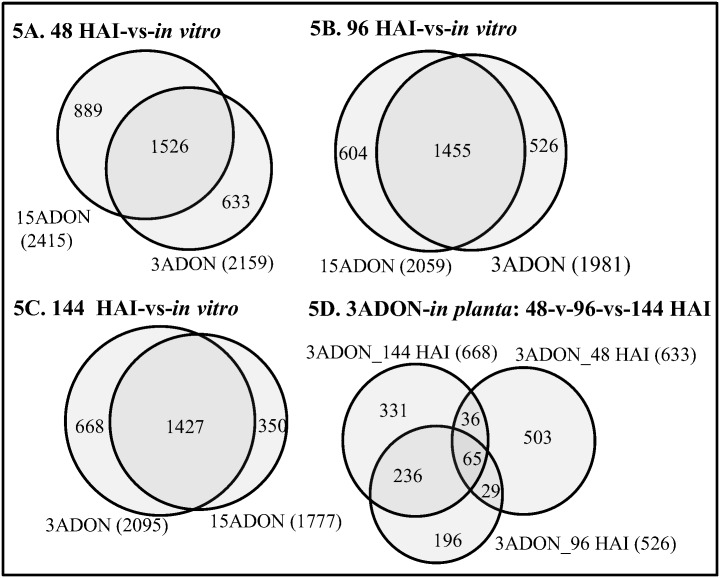
Venn diagram comparing exclusively up-regulated genes in in planta vs in vitro in the 3ADON and 15ADON populations.Samples were taken at 48 (A), 96 (B), 144 (C) hours after inoculation (HAI). D). Comparison of genes up-regulated within 3ADON population. 3ADON: population producing 3-acetyl-deoxynivalenol and DON, 15ADON: population producing 15-acetyl-deoxynivalenol and DON. Information of all genes on each Venn diagram and their functional annotation are given on S2 and S3 Tables.